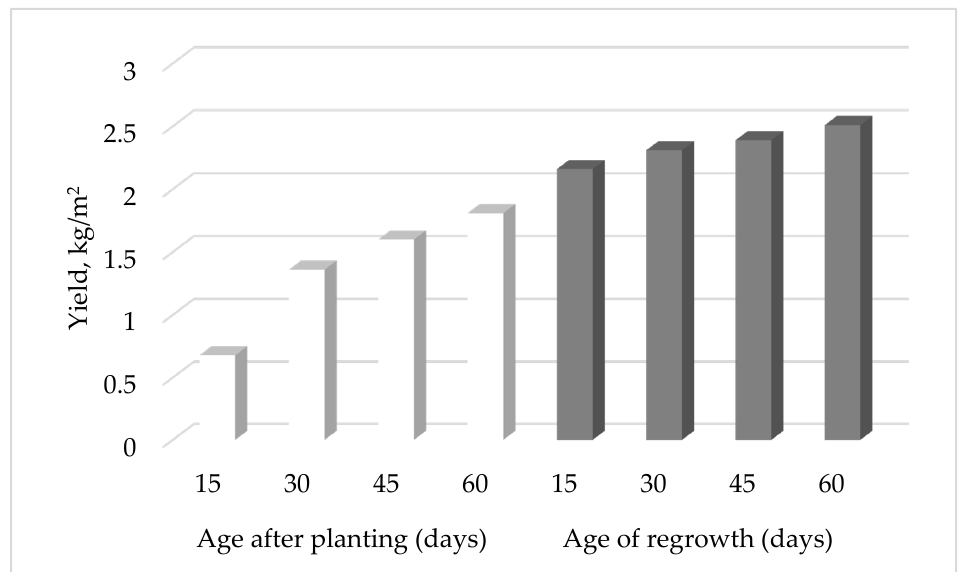
Figure 1. Brazilian spinach yield at 15, 30, 45, 60 days of age after planting and regrowth.